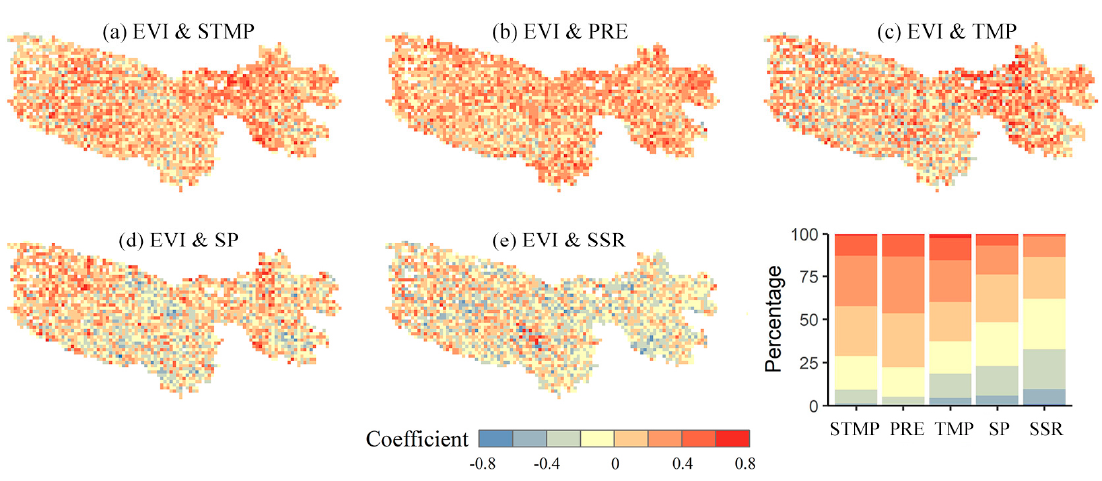
Figure 9. Spatial distributions of correlation analysis between the EVI and climatic factors (STMP ( a ), PRE ( b ), TMP ( c ), SP ( d ), SSR ( e )).